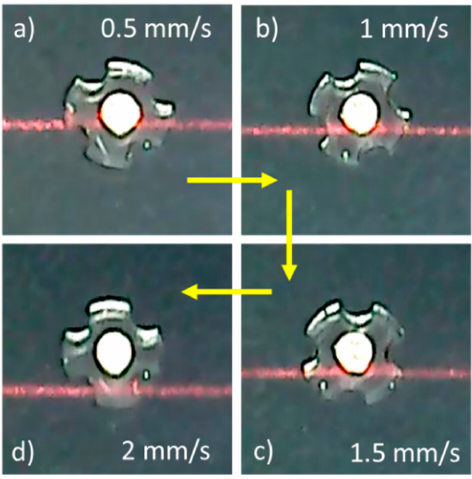
Figure 14. Depending on change of the micro-stage speed: ( a ) 0.5 mm/s; ( b ) 1 mm/s; ( c ) 1.5 mm/s; ( d ) 2 mm/s, micro-UFO delay relative to different lifter magnet speeds are shown. The red line belongs to the laser which is sent from the center of the lifter magnet.